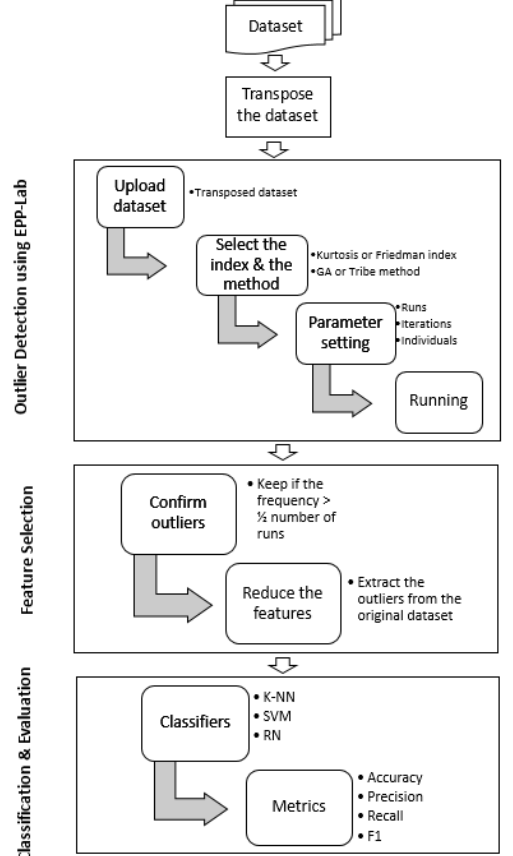
Figure 5. Projection Pursuit-based feature-selection